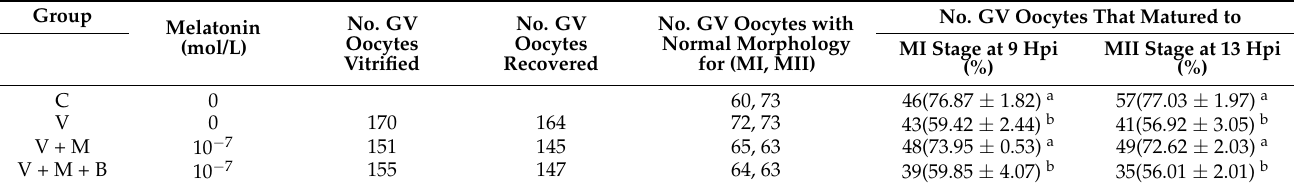
Table 2. In vitro development of vitrified mouse GV oocytes after melatonin and Brusatol treatment. Group Melatonin (mol/L)